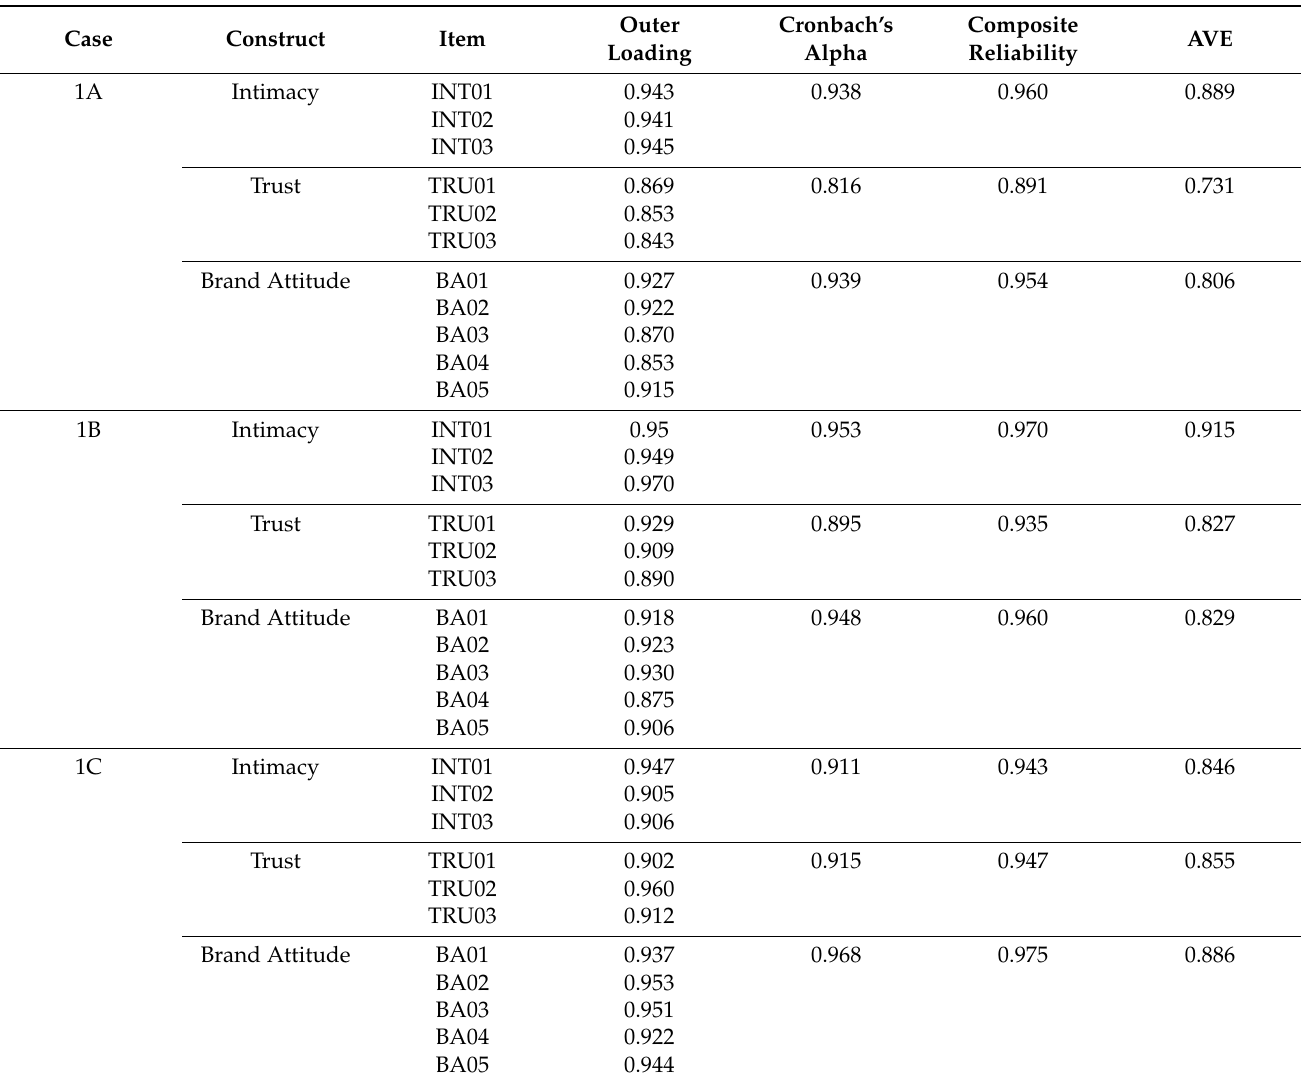
Table A2. Construct Validity and Reliability of each case in Delivery Service